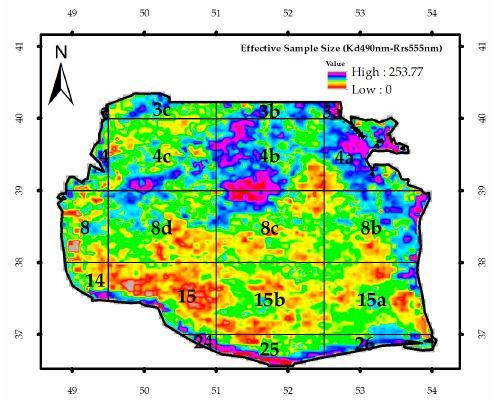
Figure 3. The image of the e ff ective sample size ( n e ).